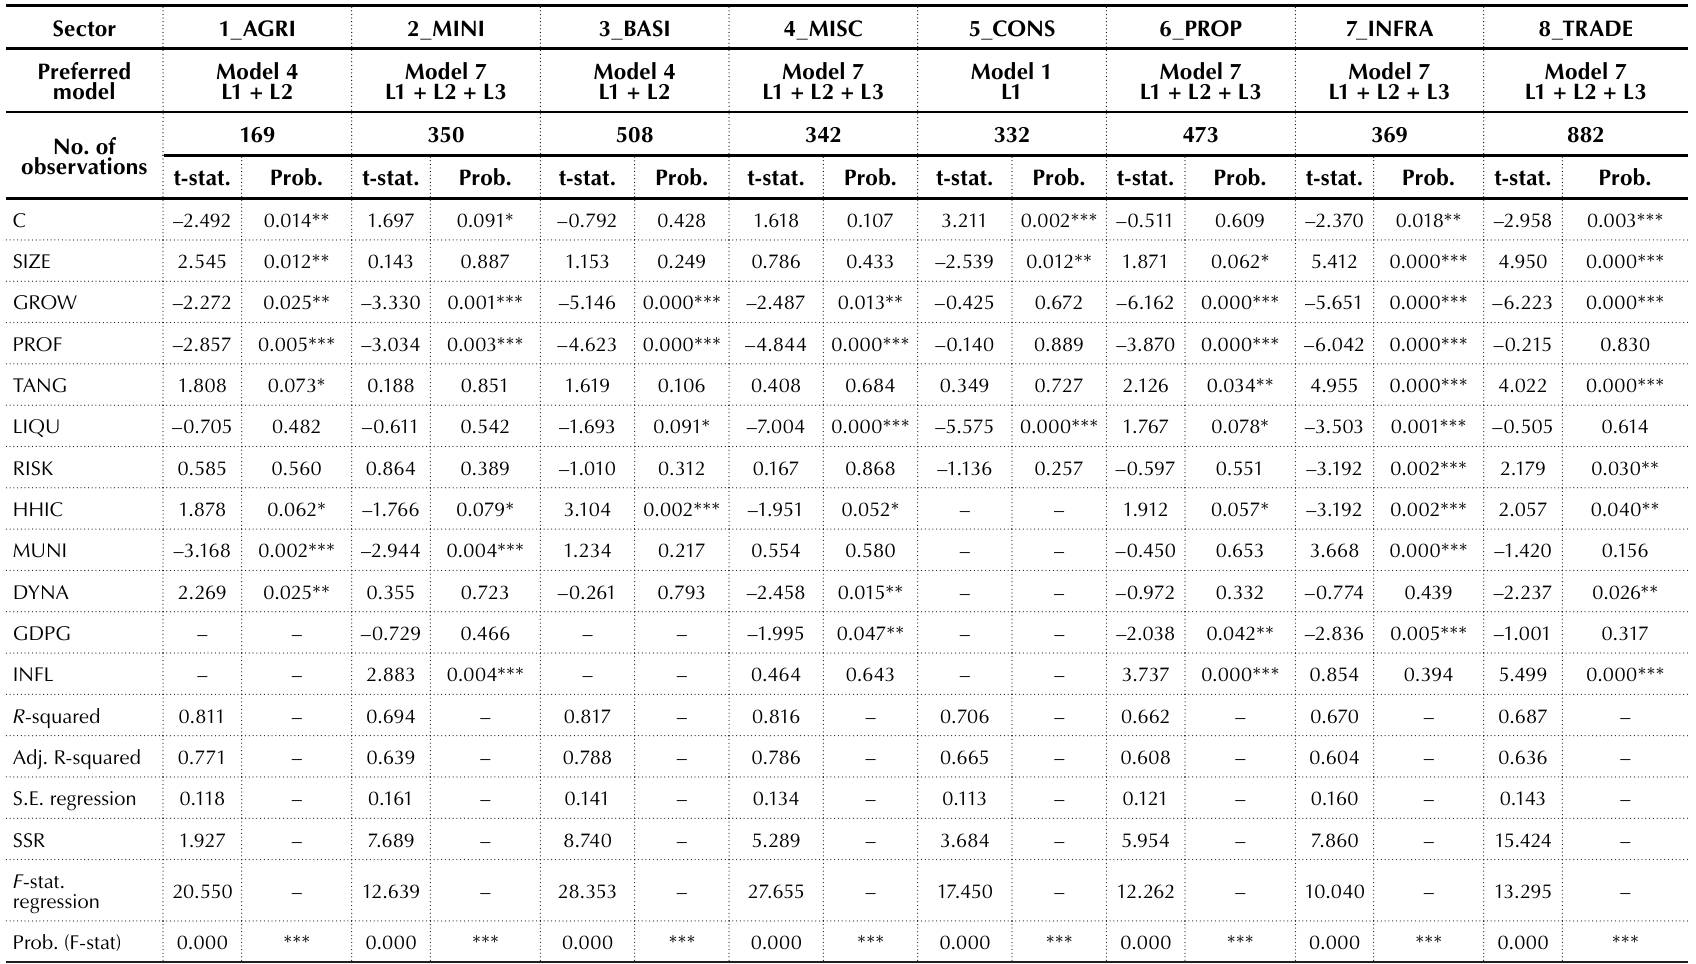
Table 7. Regression results of preferred relationship model between debt ratio and its determinants – across